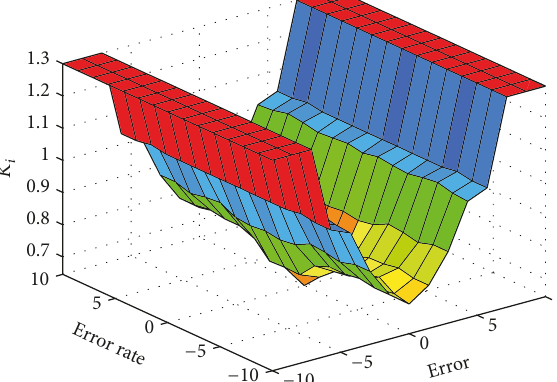
Figure 10: Error and derivative error for the output 𝑘 𝑖 .